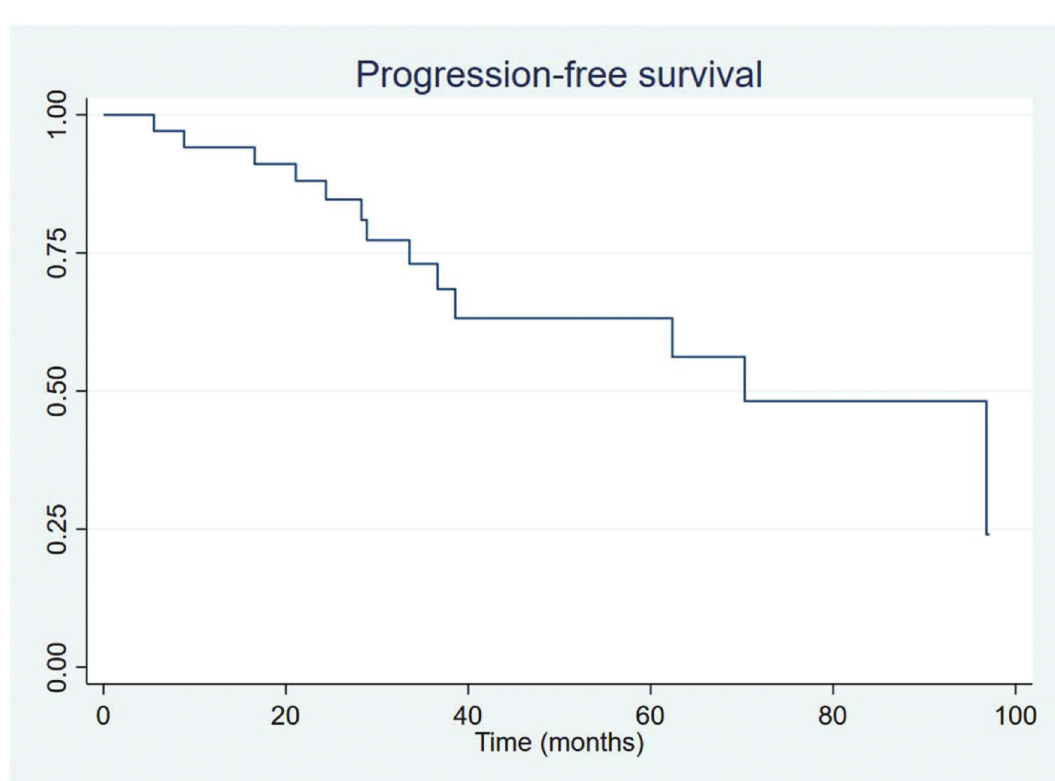
Fig 3 - Survival free of in-field progression.